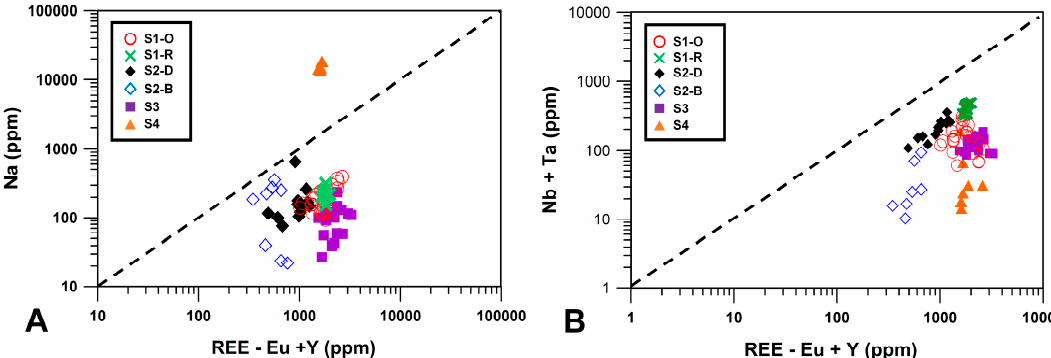
Figure 7 . ( A ) Plot versus Na concentration and (REE–Eu + Y) concentration. The dashed line in the center is the ideal 1:1 correlation line. Most scheelites have a higher amount of REE than Na, which means that Na did not play significant role in the REE substitution of scheelite. Extraordinary abundance of Na in stage IV scheelite might be affected by later-stage sodium alteration, which produced stilbite in the quartz–scheelite veins of the footwall orebody. ( B ) Plot versus Nb + Ta and (REE–Eu + Y) concentration. The dashed line in the center is the ideal 1:1 correlation line. Scheelite has a higher amount of REE than Nb + Ta, which means that Nb + Ta also was not a main substitution mechanism of the deposit.